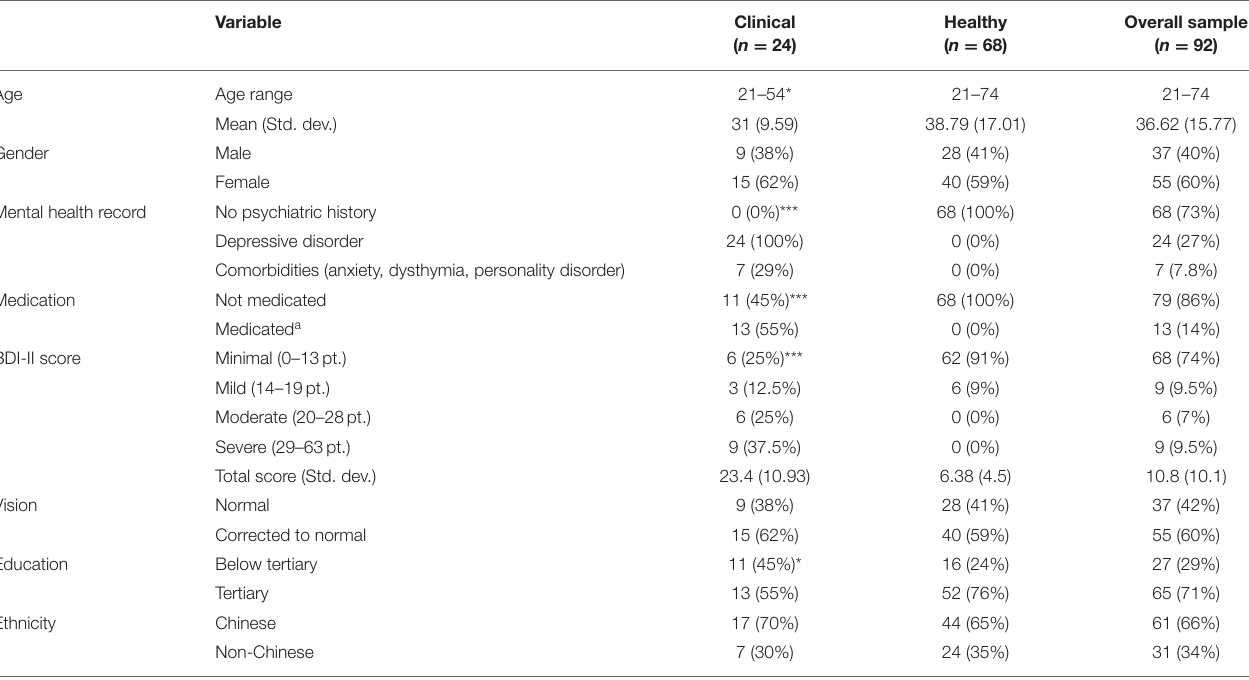
TABLE 1 | Recruited sample characteristics within both Clinical and Healthy